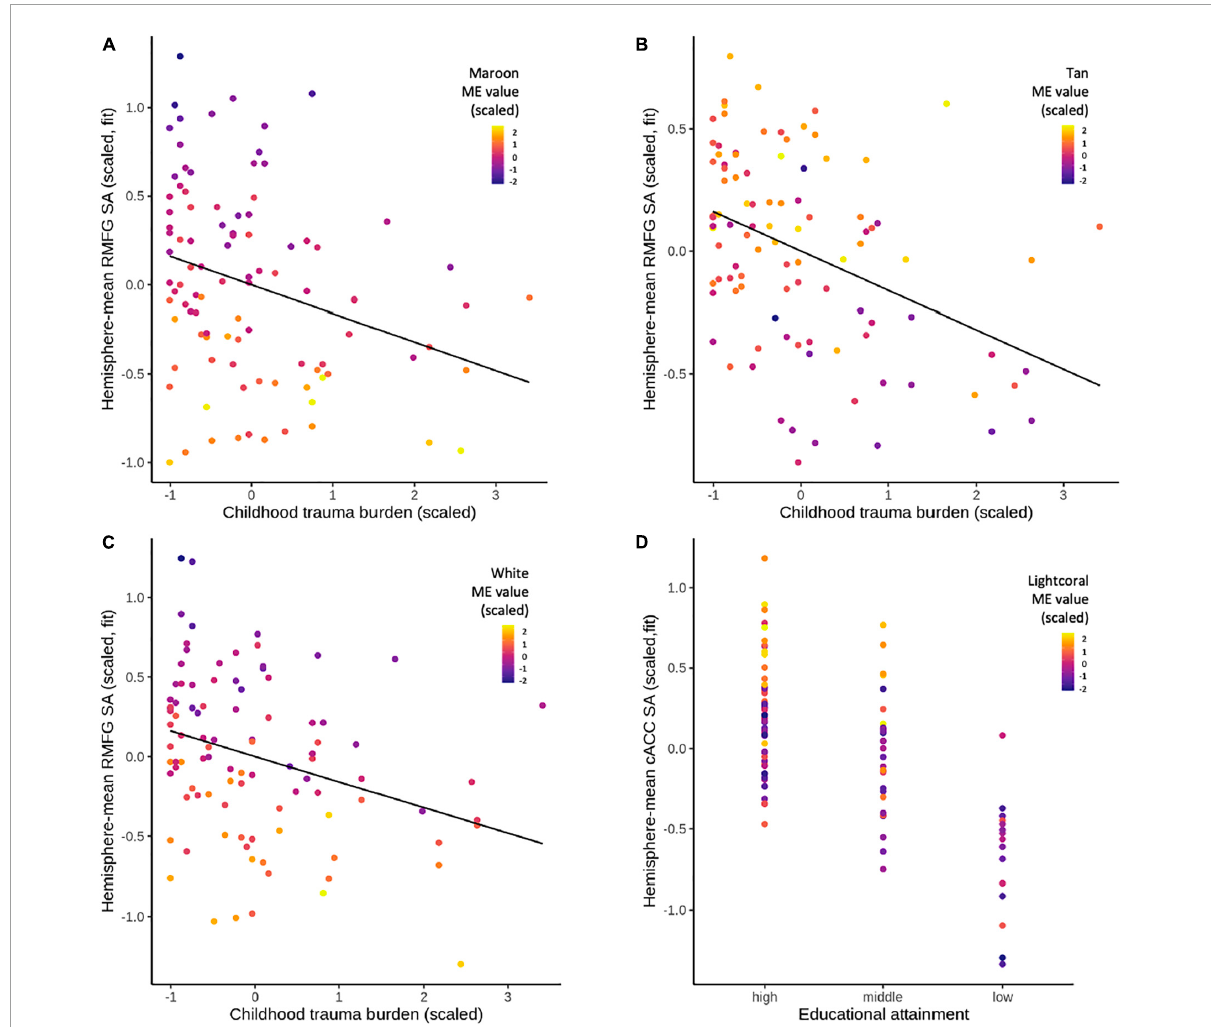
FIGURE3 Dependent and independent variables were scaled. (A) CTQ total was positively associated with the Maroon ME ( β = 0.289, SE = 0.109, t = 2.639, p = 9.8 × 10 - 3 ). In turn, the Maroon ME was negatively associated with RMFG SA ( β = − 0.451, SE = 0.091, t = − 4.966, p = 3 × 10 - 6 ). (B) CTQ total was negatively associated with the Tan ME ( β = − 0.248, SE = 0.112, t = -2.220, p = 0.029). The Tan ME was, in turn, positively associated with RMFG SA ( β = 0.233, SE = 0.100, t = 2.322, p = 0.023). (C) CTQ total was positively associated with the White ME ( β = 0.236, SE = 0.110, t = 2.151, p = 0.034). In turn, the White ME was negatively associated with RMFG SA ( β = − 0.392, SE = 0.093, t = − 4.231, p = 6 × 10 - 5 ). (D) Low educational attainment (no high school certificate) was associated with the Lightcoral ME ( β = − 0.615, SE = 0.296, t = -2.079, p = 0.040). The Lightcoral ME, in turn, was positively associated with cACC SA ( β = 0.215, SE = 0.099, t = 2.182, p =